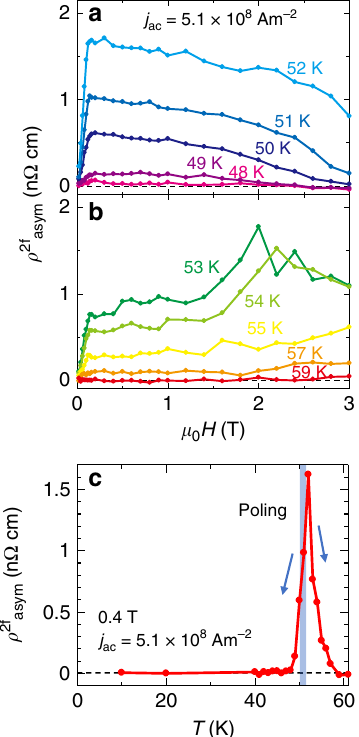
Fig. 4 Temperature and magnetic fi eld dependencies of magnetochiral at various temperatures effect. a , b Magnetic fi eld dependence of ρ 2 f asym measured after the poling procedure at 51 K with j p = 1.1 × 10 9 Am − 2 . at 0.4 c Temperature dependence of ρ 2 f asym